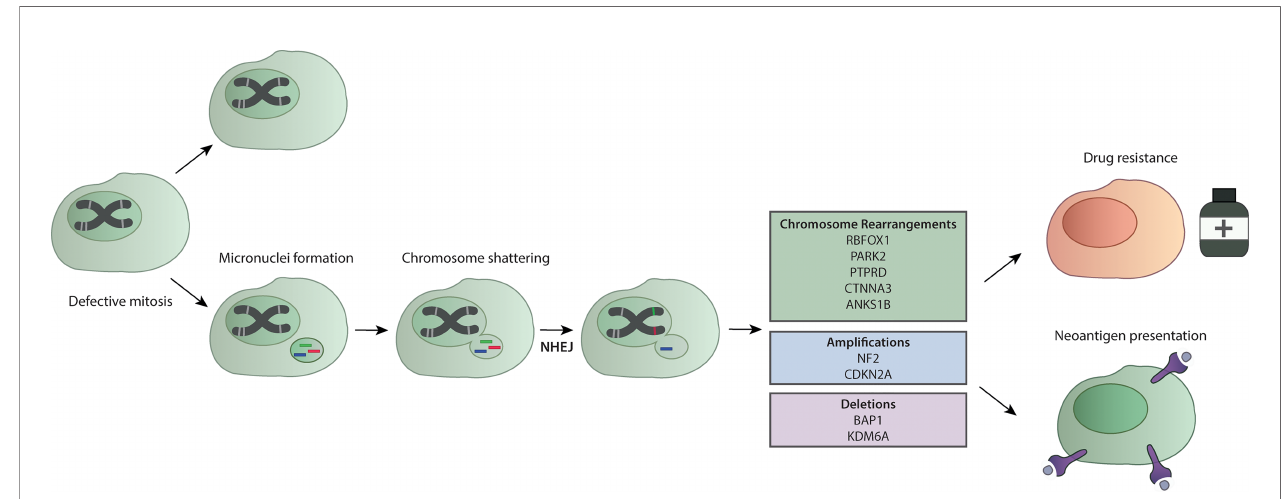
FIGURE 3 | Chromotripsis in mesothelioma. A defective mitosis process leads to the formation of micronuclei. Further replication leads to chromosome shattering and the addition of genetic material through the NHEJ. This process forms chromosome rearrangements that in MPM interest genes like RBFOX1, PARK2, PTPRD, CTNNA3 and ANK51B , and are linked to ampli fi cation of key MPM genes like NF2 and CDKN2A , or the loss of genetic material of BAP1 and KDM6A (113, 150, 151). Ampli fi cation of oncogenes due to chromotripsis has been recently associated with drug resistance (152). The extensive chromosomal breakage upon chromotripsis events leads to neoantigen presentation that can make cells more sensitive to immunotherapy